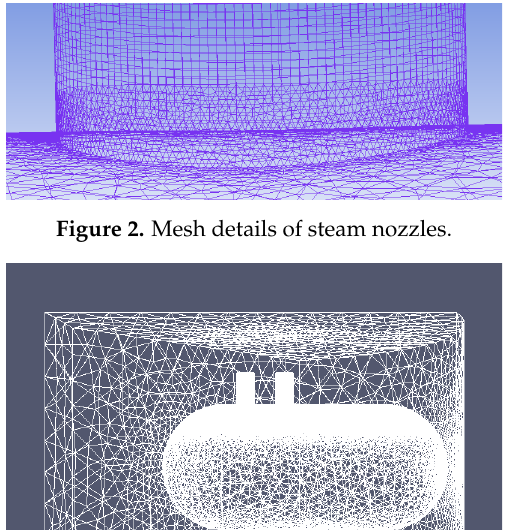
Figure 1. Schematic and principal dimensions of PRT (pressurizer relief tank) and interior space ( a ) in front view; ( b ) in top view. (all dimensions are in mm)